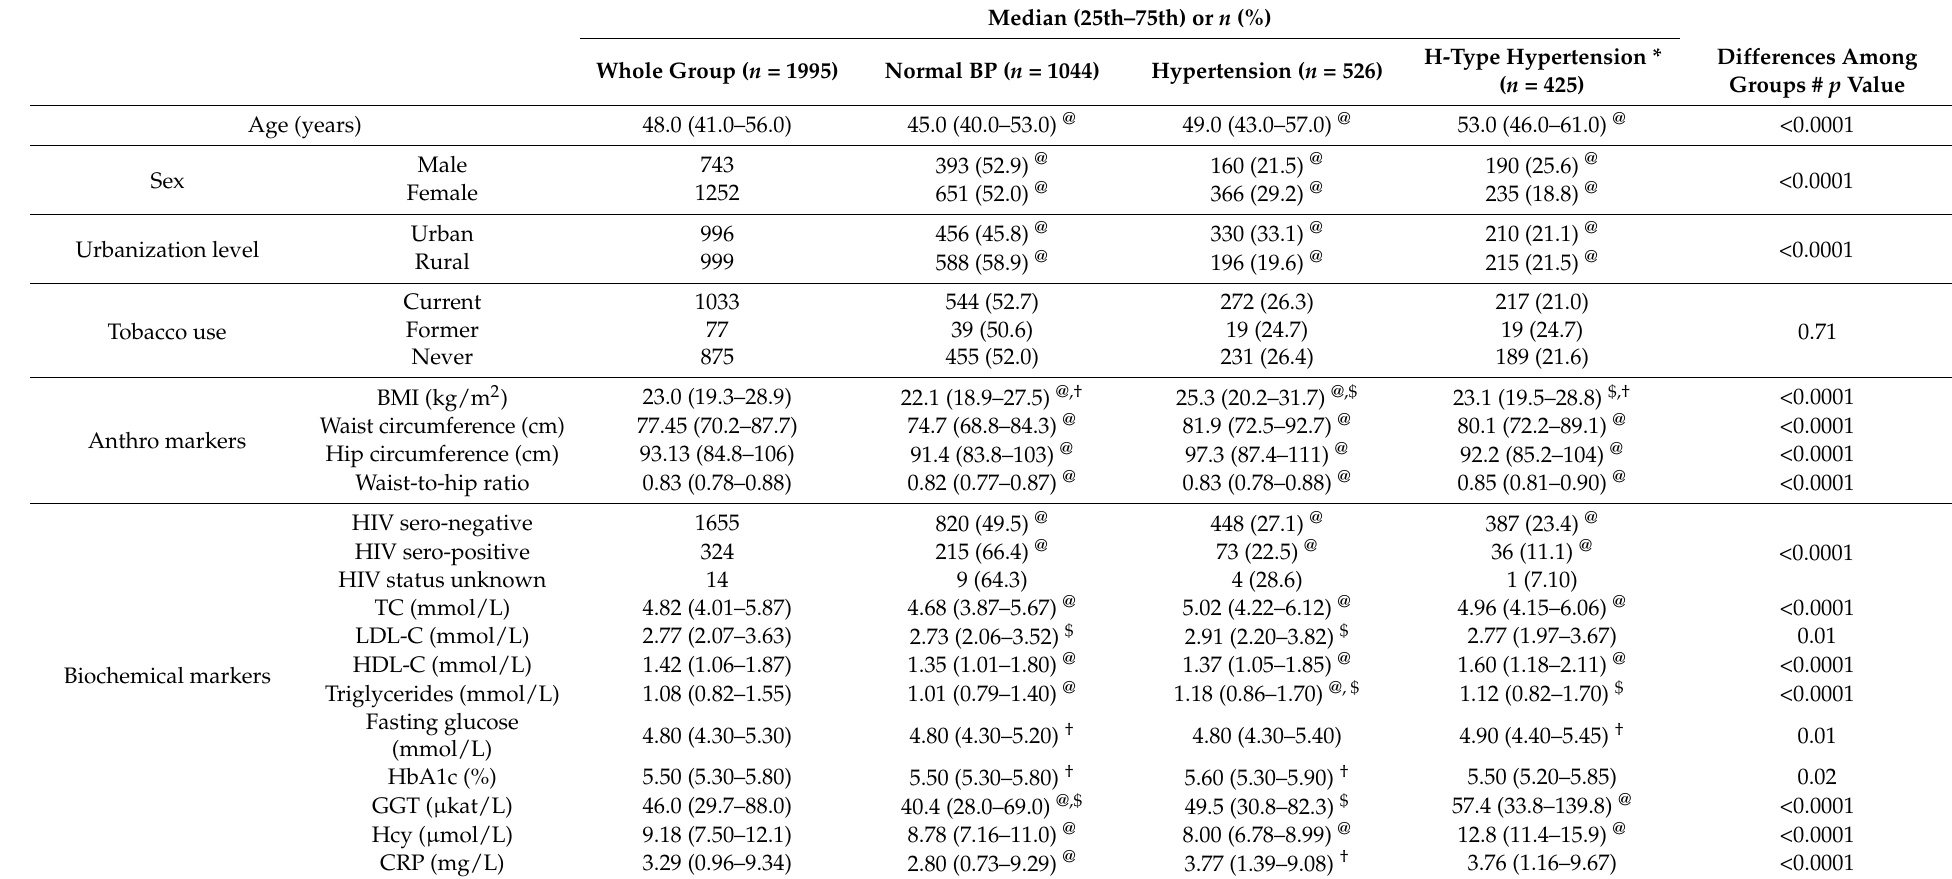
Table 1. Demographic characteristics of participants over blood pressure